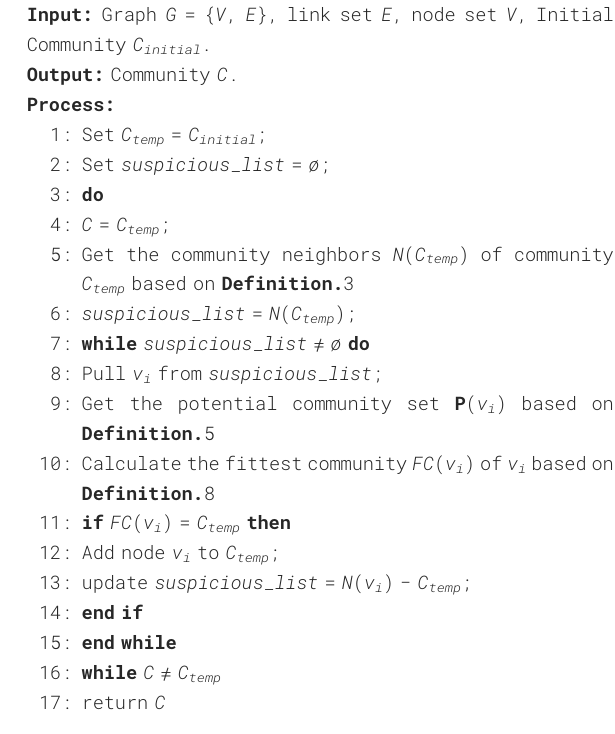
Algorithm 4. Community